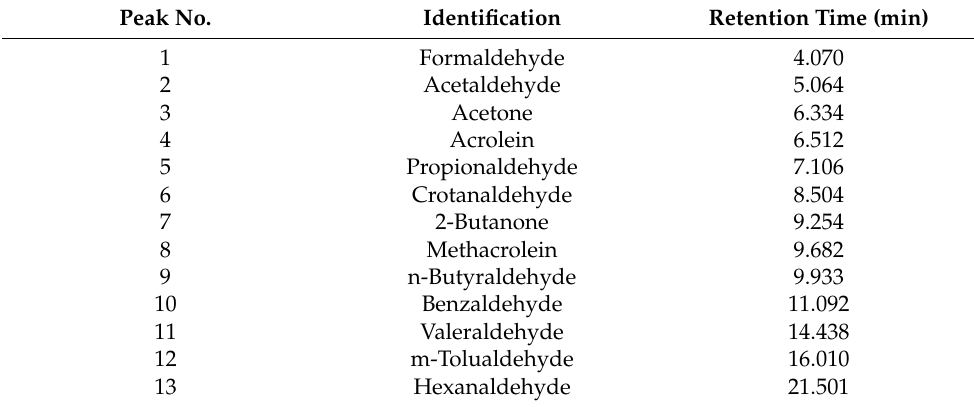
Table 3. Aldehyde and Ketone Peak